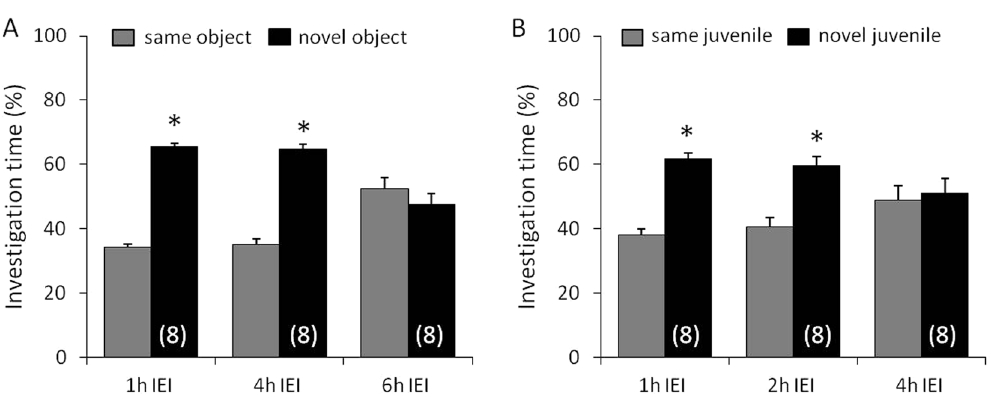
Figure 1. Non-social memory is retained for at least 4 h, whereas social memory for at least 2 h. Percentage investigation of the same and the novel object ( A ) or juvenile ( B ) during the discrimination period of the object and social discrimination test, respectively. Intact memory and discrimination abilities are reflected by an increased investigation of the novel versus the same stimulus after a defined inter-exposure interval (IEI). Data represent means + SEM, and numbers in parentheses indicate group sizes. * p < 0.05 versus same